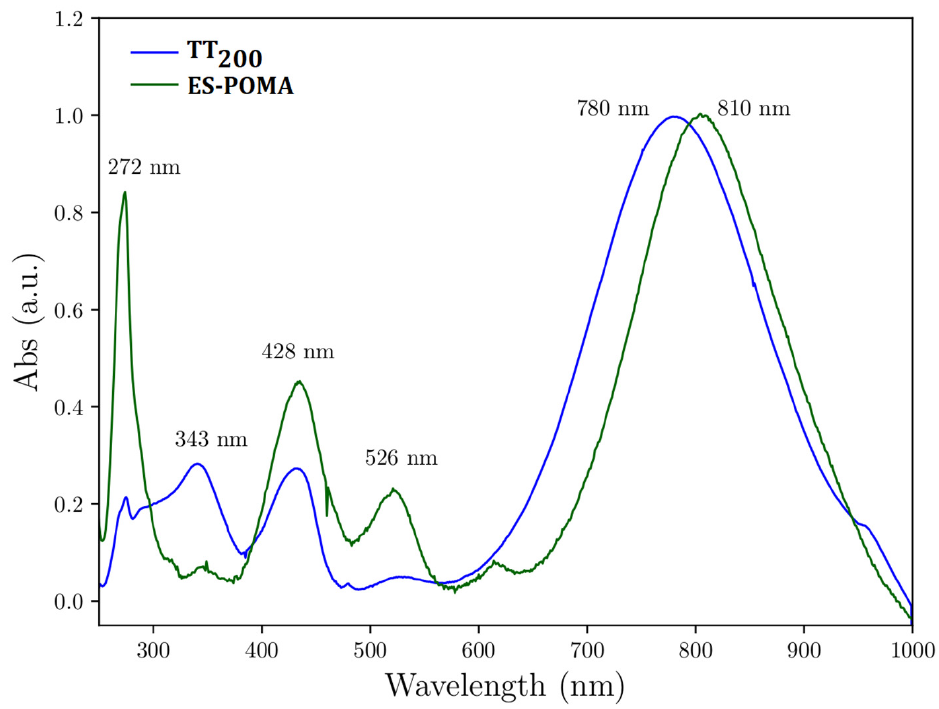
Figure 4. UV-VIS spectra of ES-POMA and TT 200 .